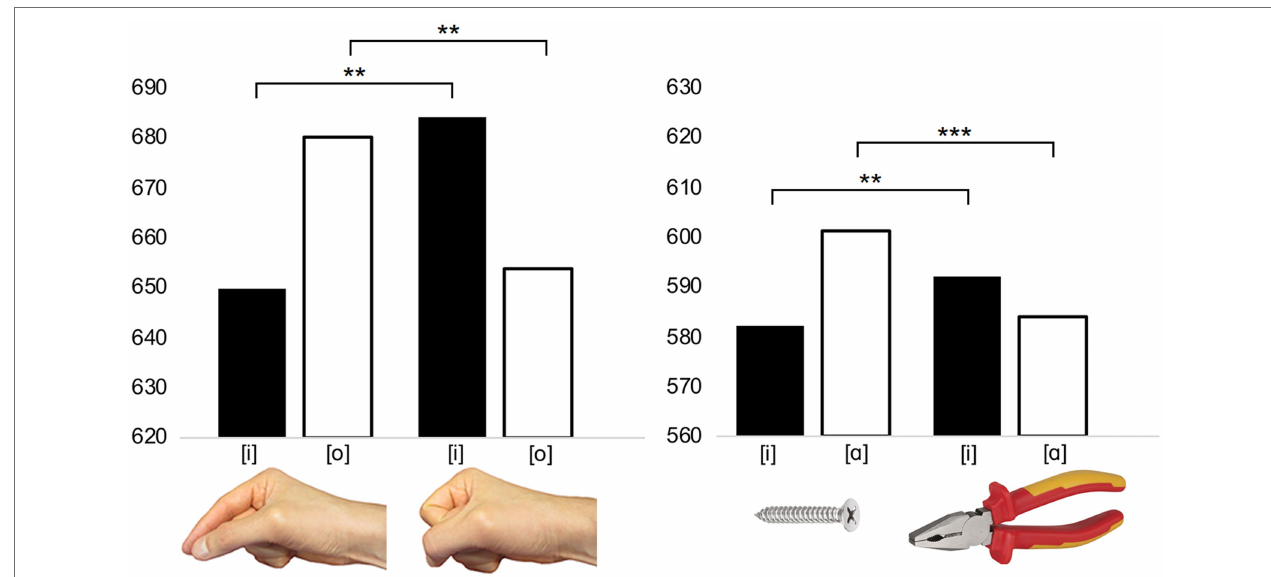
FIGURE 2 | (Left) The RT effect for the study published by Vainio et al. (2017a). In the experimental task, the participants were presented with an image of a hand- shaped into the precision or power grip. The participants had to respond, as quickly as possible, by vocalizing the [i] or [o] according to the perspective (above/front) of a hand. [i] responses were produced particularly rapidly when the hand was shaped into the precision grip, and [o] was produced particularly rapidly when the hand was shaped into the power grip. (Right) The RT effect for study published by Vainio et al. (2019a). In the experimental task, the participants were presented with an image of an object whose size was compatible with the precision or power grip. The participants had to respond by vocalizing [i] or [a] according to the category of the object (manufactured/natural). [i] responses were produced particularly rapidly when the object’s size was compatible with the precision grip, while [a] responses were produced particularly rapidly when the size was compatible with the power grip. Asterisks indicate statistically significant differences (*** p < 0.001; ** p <